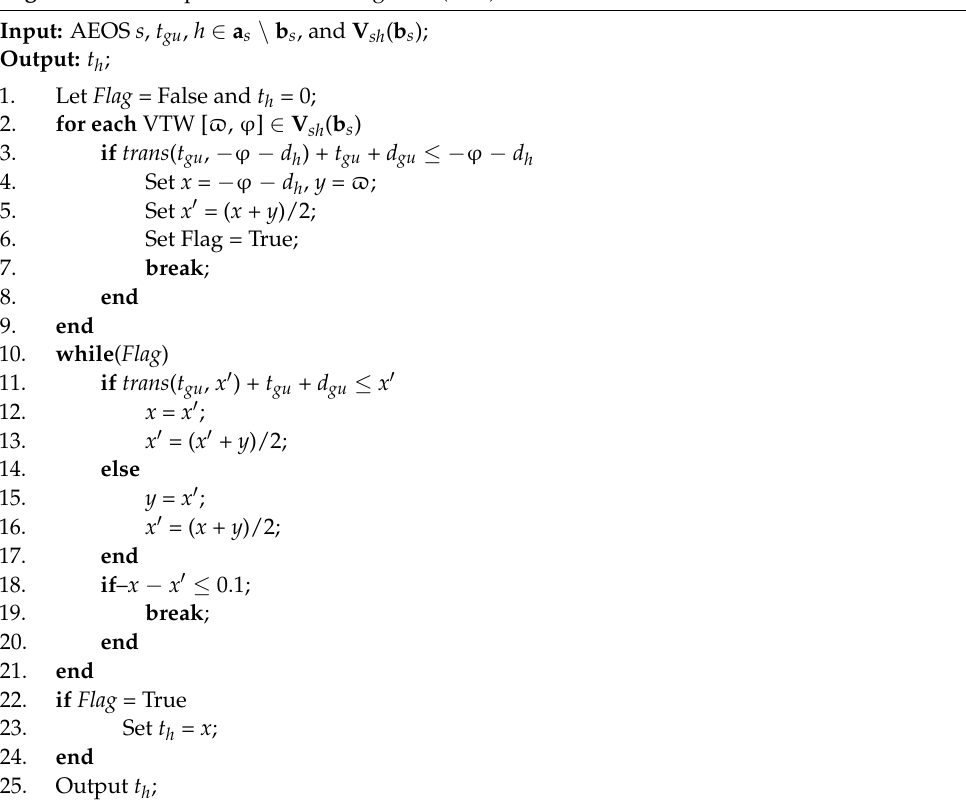
Algorithm 2: Compute start-observing time